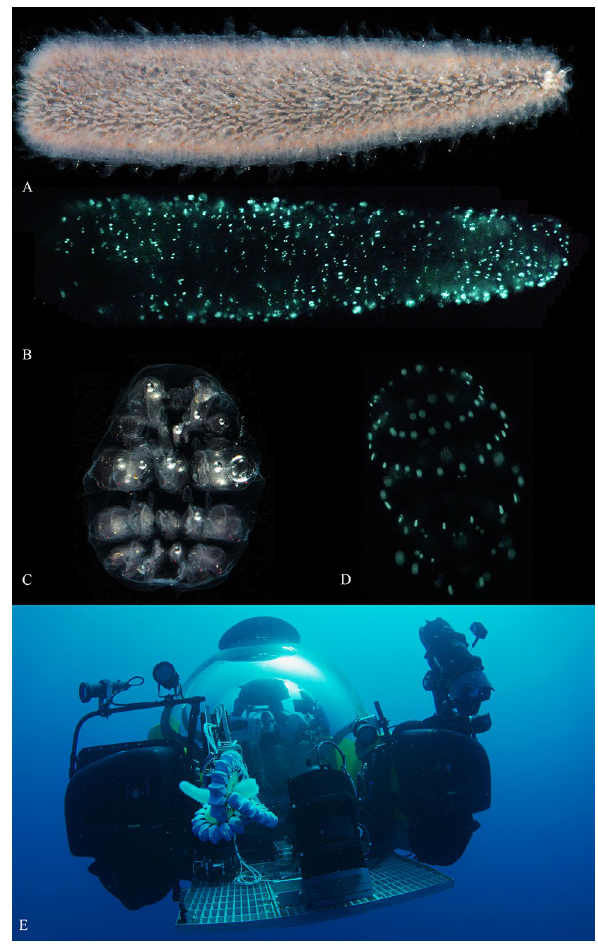
Figure 1. Pyrosomes— Pyrosoma atlanticum ( A , B ; ~ 155 mm × 40 mm) and Pyrosomella verticillata ( C , D ; ~ 25 mm × 40 mm)—from SE Brazilian Atlantic under ( A , C ) white light and ( B , D )